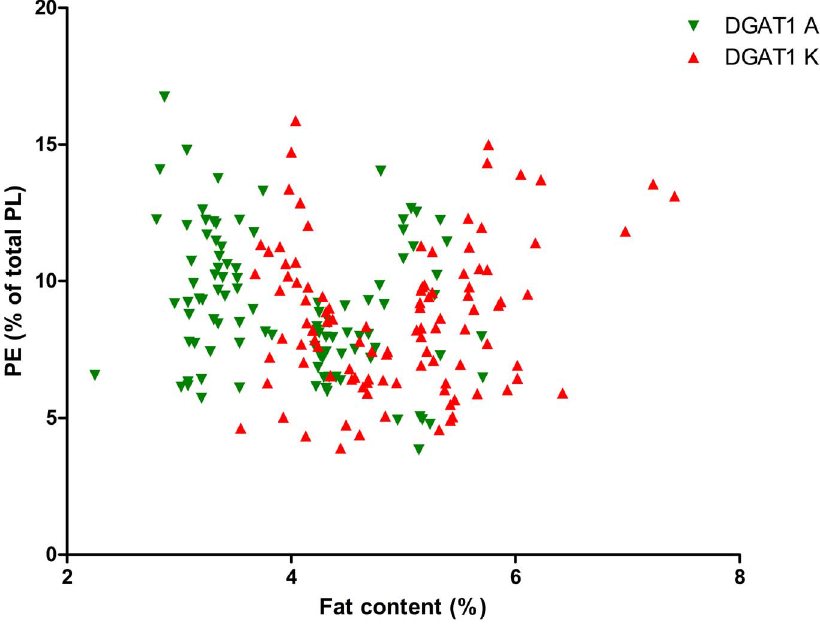
Figure 3. Relationship between fat content (%) and phosphotidylethanolamine (PE) content (% of total phospholipids (PL)) differentiated by DGAT1 genotype.